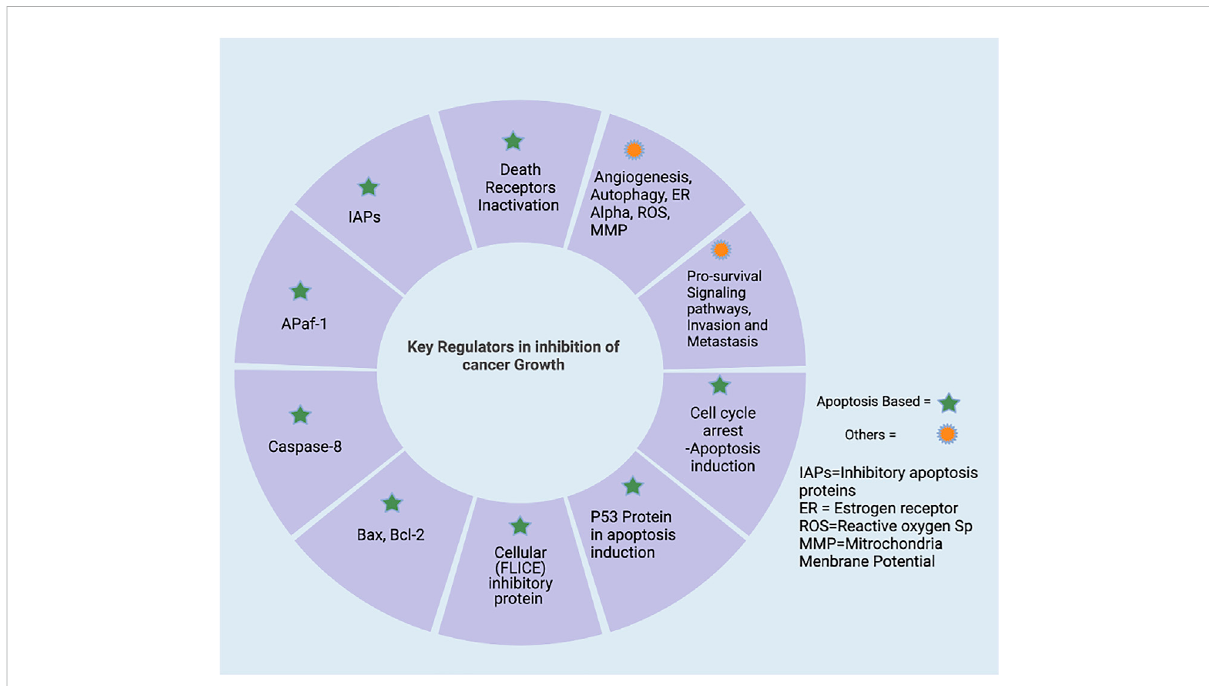
FIGURE 2 Targetingregulatorsininhibitionofcellprogression.Itismainlydividedintoapoptosisregulatorsandothers.TargetingApoptosisincludesi)up- regulation ofpro-apoptotic (caspases protein,Bax, andpro-apoptotic member ofBcl-2family)ii)down-regulation ofanti-apoptotic proteins (IAPs). Also, by targeting the pro-survival signaling pathways, invasion and metastasis proteins dysregulated in cancer cells, created with